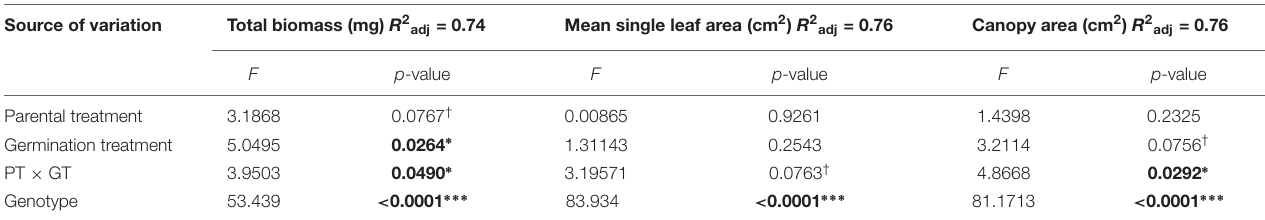
TABLE 2 | Results of significance tests for effects of shade versus sun parental treatment (PT), control versus demethylation germination treatment (GT), and genotype on seedling traits based on a three-way ANOVA ( N = 152; details in Materials and Methods). Source of variation